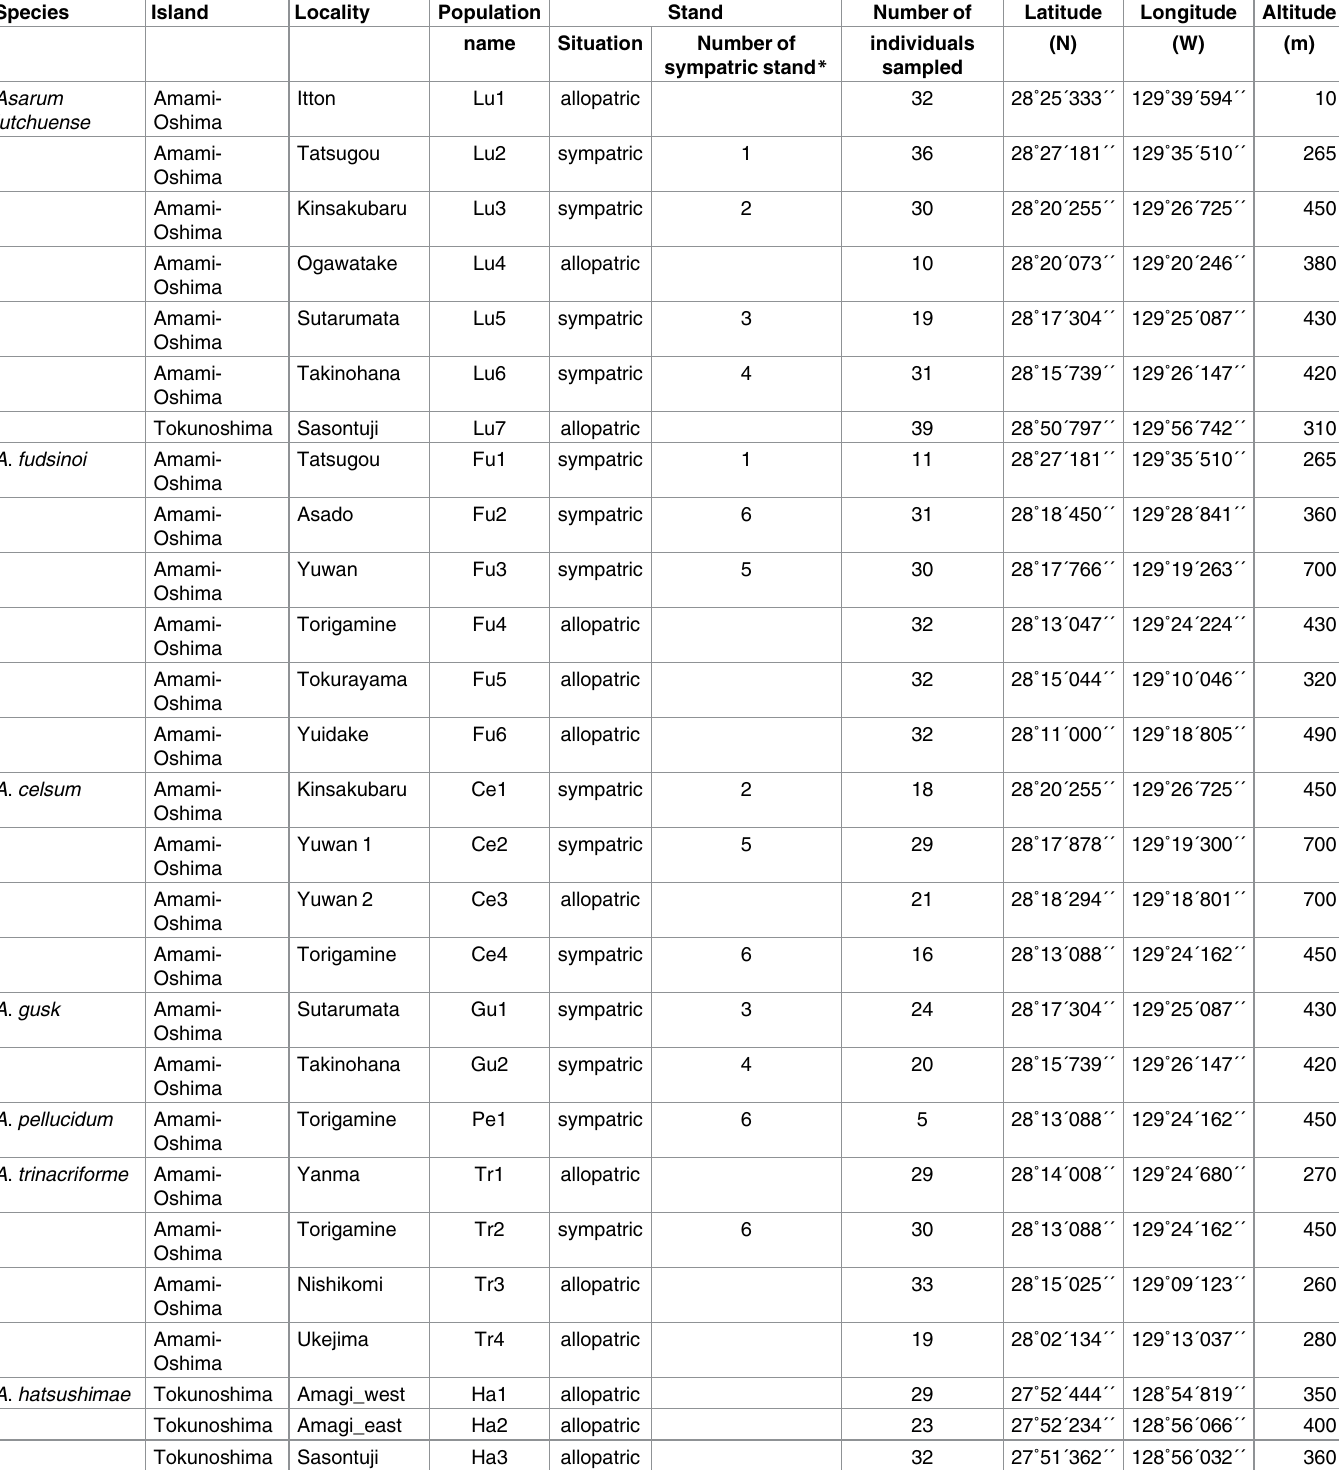
Table 1. Sample information for 32 populations of Asarumon Amami Group.